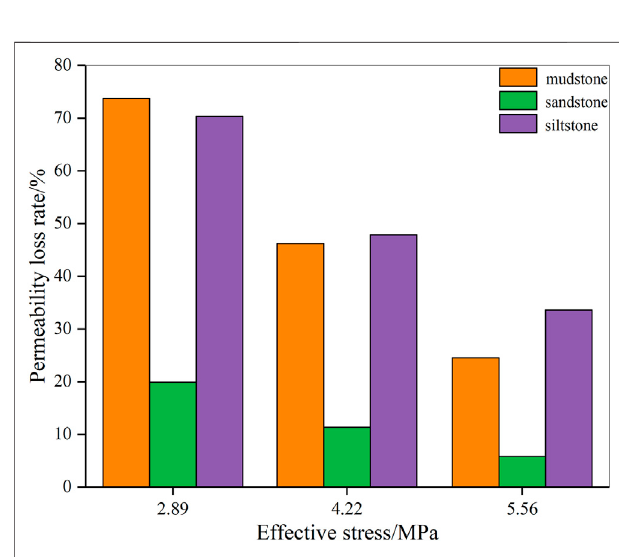
Frontiers in Earth Science |